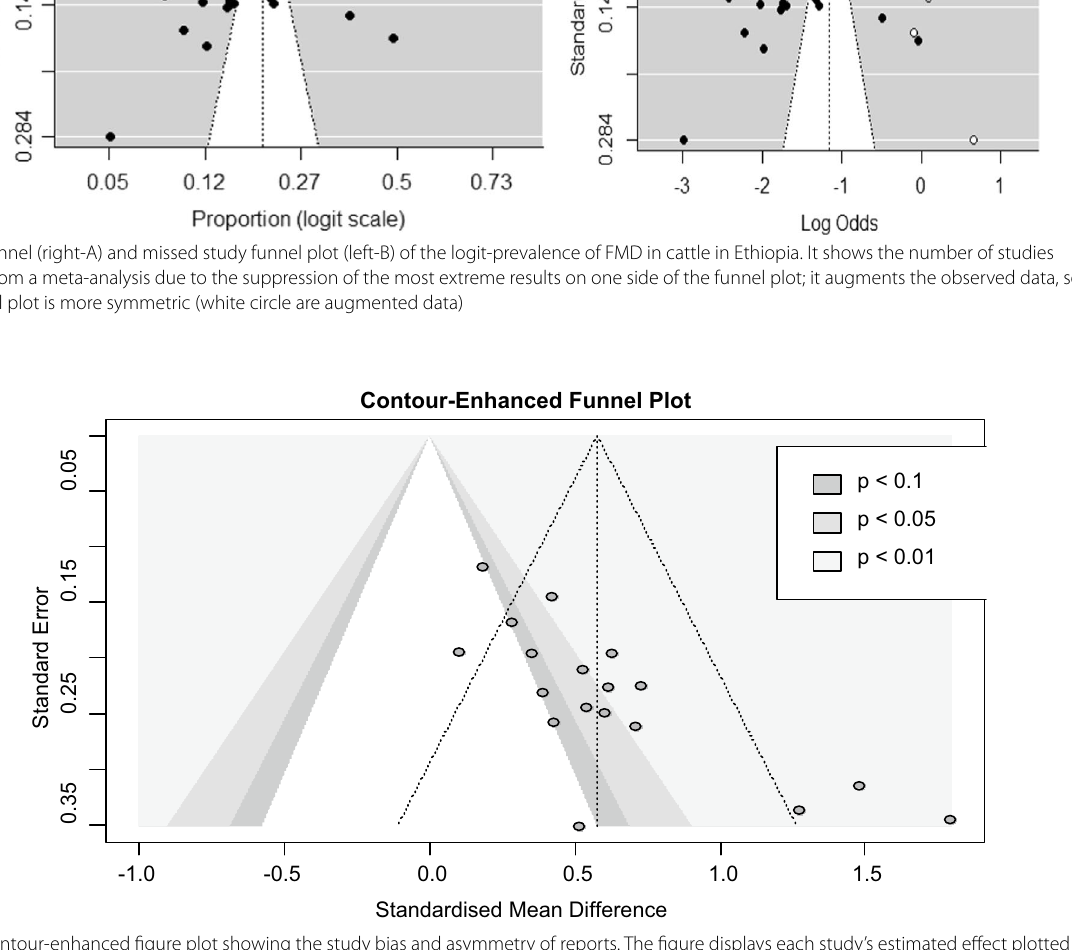
Fig. 5 Contour-enhanced figure plot showing the study bias and asymmetry of reports. The figure displays each study’s estimated effect plotted against its SE and evaluates the relationship between study results and their precision (dot line plotted funnel